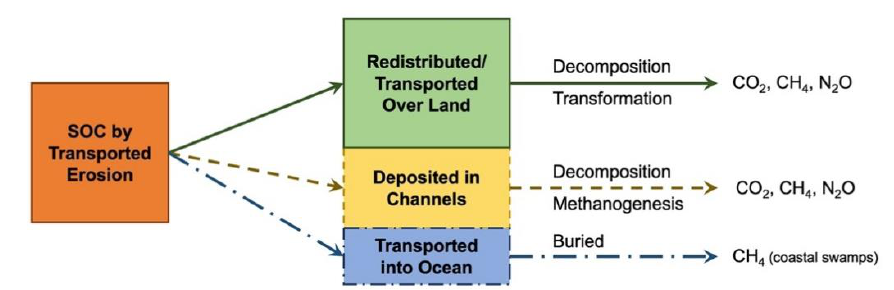
Figure 2. The fate of soil organic carbon transport by erosion. About 40%–50% may be redistributed over the land, 20%–30% may be deposited in channel, 5%–15% may be carried into the ocean, and about 15%–20% may be emitted into the atmosphere. However, the exact partition may vary among soil, climate, land use, and other site-specific factors. Whereas the cumulative emission of CO 2 may decrease at the eroded site, it may increase at the transported and depositional zones.